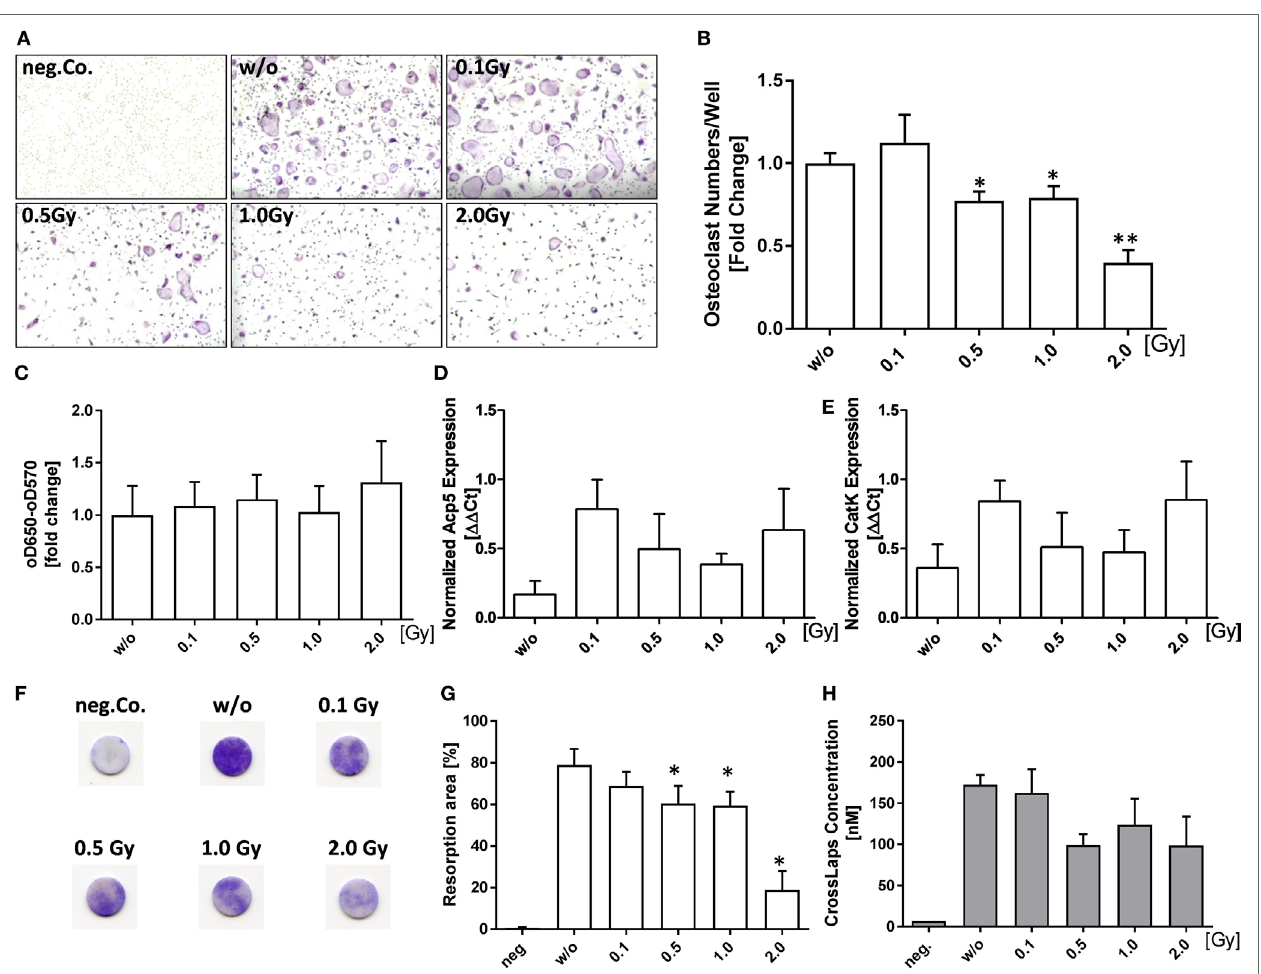
FigUre 2 | Low-dose irradiation reduces the numbers and activity of differentiated inflammatory osteoclasts. Differentiation of h TNF- α tg bone marrow cells into osteoclasts (OCs) was carried out in the presence of 10 ng/ml M-CSF and 50 ng/ml RANK-L. Cells were irradiated with the depicted doses of X-rays 24 h after seeding. Differentiated cells were stained for tartrate-resistant acid phosphatase (TRAP). Representative images where taken at 5 × magnification (a) . OC numbers of three fields/well, taken at 5 × magnification, were counted and OC numbers of each well were pooled. TRAP + cells with three or more nuclei were considered to be OCs (B) . Cell viability was analyzed by MTT assay (c) . Total mRNA from differentiated OCs was isolated using phenol–chloroform extraction and quantitative real-time PCR (qPCR) for Acp5 and CatK using SYBR Green was carried out (D,e) . Depicted is joint data from differentiated pooled bone marrow of total 7 h TNF-